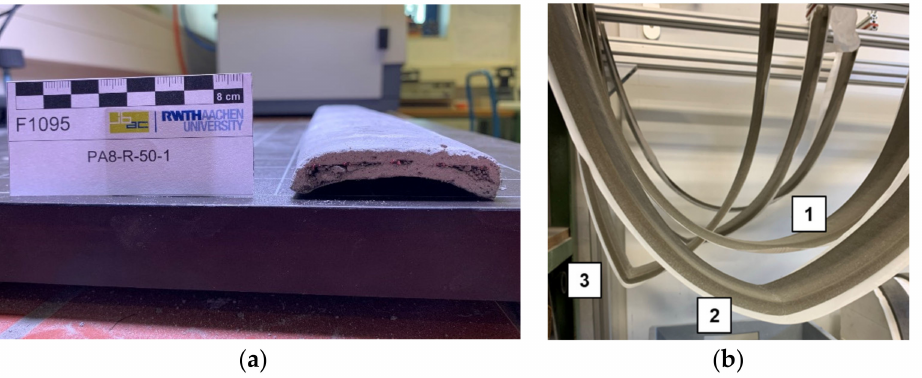
Figure 11. ( a ) Extruded and subsequently transversely formed carbon TRM specimen; ( b ) extruded and subsequently longitudinally formed carbon TRM